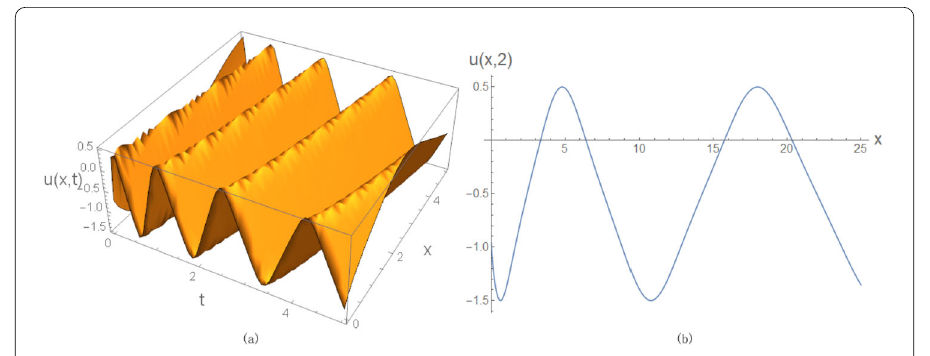
Figure 8 ( a ) Three-dimensional figure of (71), when κ = 1, c = 11, and ξ 0 = 1; ( b ) the corresponding two-dimensional figure when t = 0.2